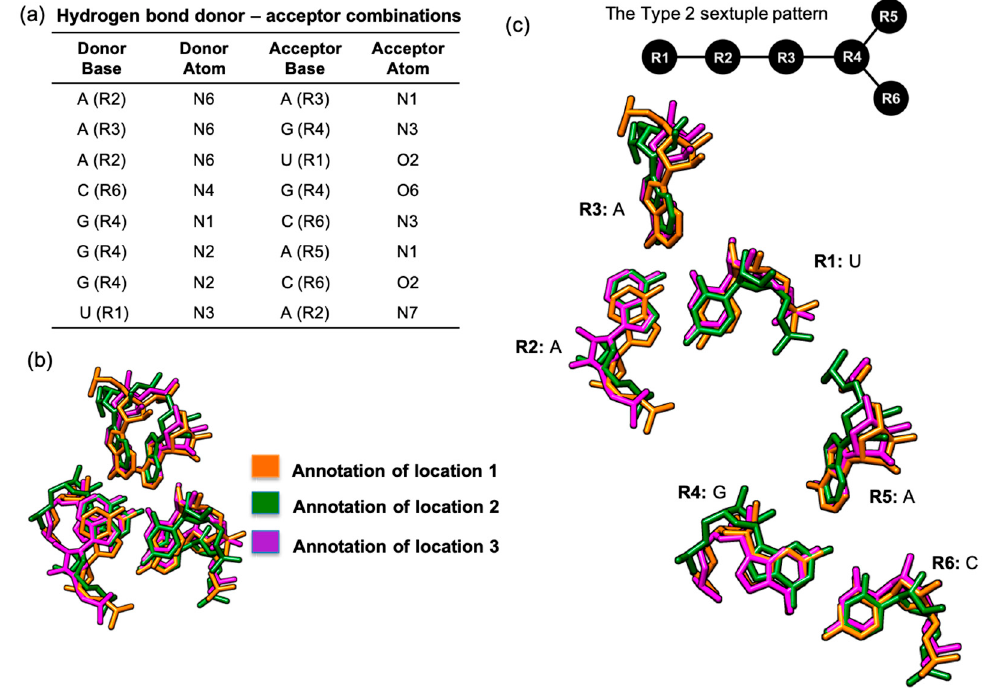
Figure 6. The UAAGAC base sextuple that was annotated in three locations in the same RNA molecule, a large ribosomal subunit structure (PDB ID: 4LT8). (a) Table of the hydrogen bond donors and acceptors that define the hydrogen-bonded base network; (b) superposition of three similar base arrangements as they can be viewed in the three different locations in same ribosomal subunit structure; (c) graphical representation of the hydrogen bond network for the Type 2 sextuple pattern and the corresponding base-by-base view of the superposed bases in the three different locations of the ribosomal subunit structure.